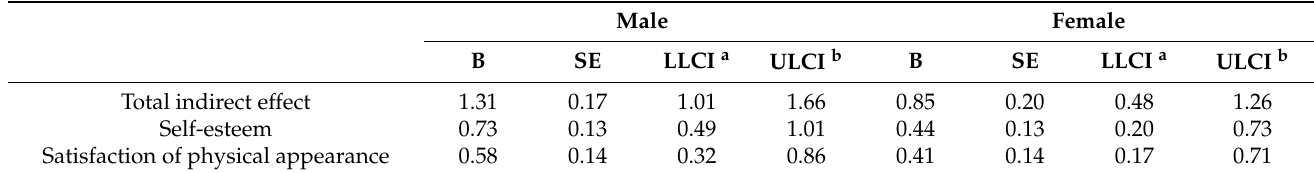
Table 6. Bootstrapping results by gender. Male Female B